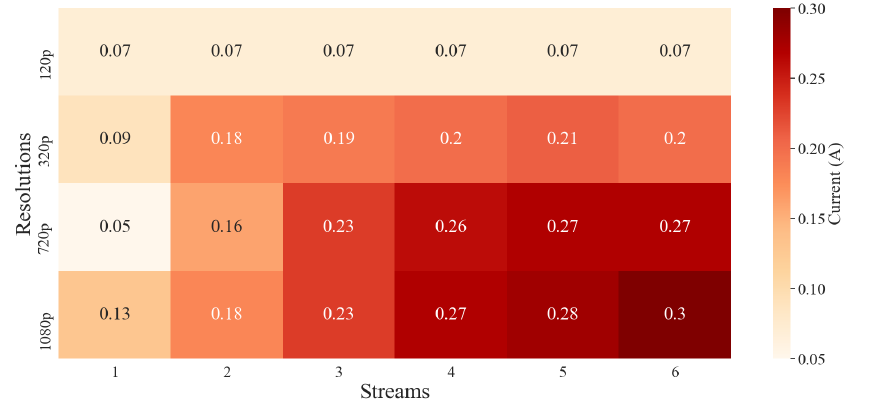
Figure 18. A heat map of average current draws on the Android device while running a number of streams.